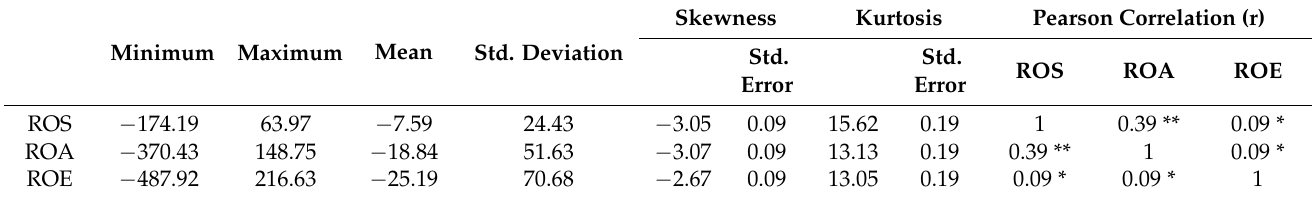
Table 5. Descriptive Statistics (N = 640)—Romanian companies sample (without